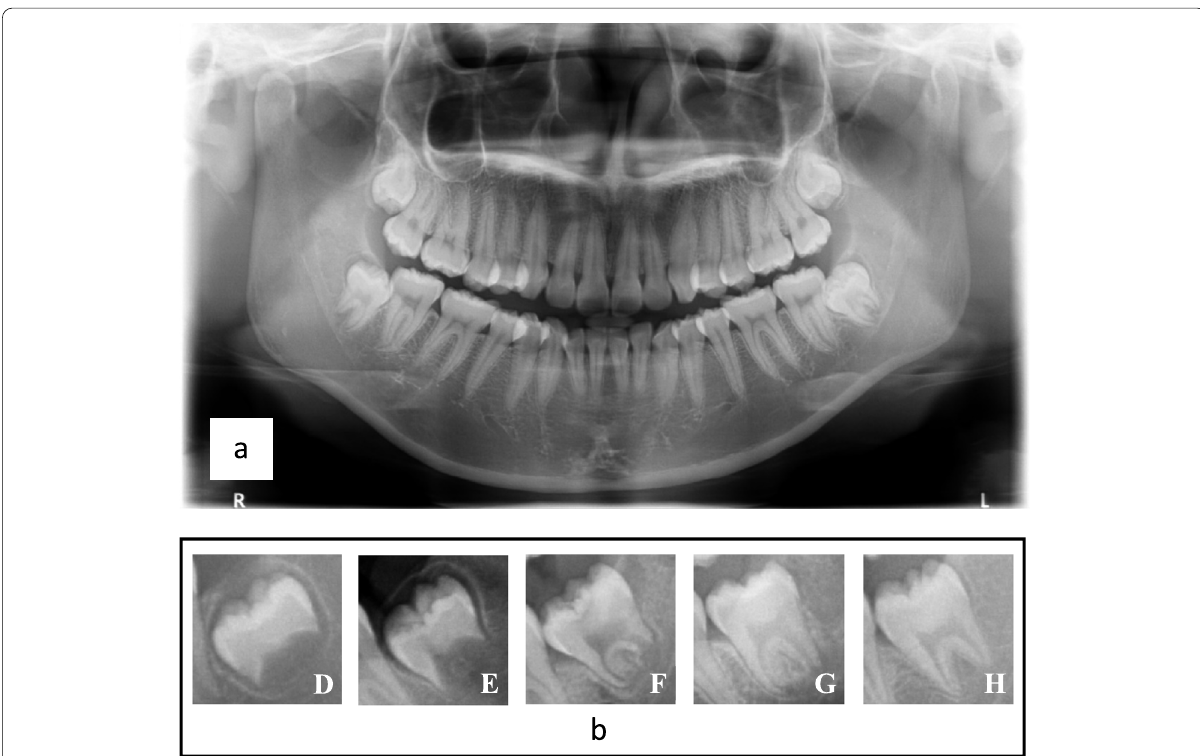
Fig. 1 Examples of images used in this study. a A panoramic image and b cropped images that covered the lower left third molar including stages D to